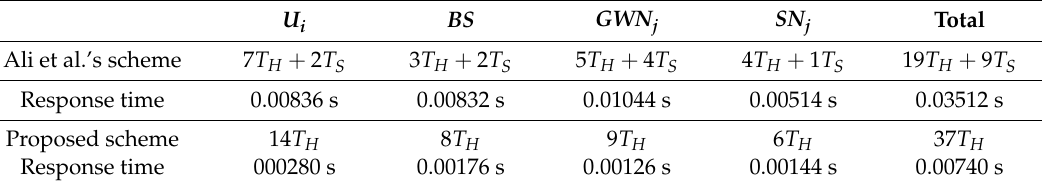
Table 4. Performance comparisons.